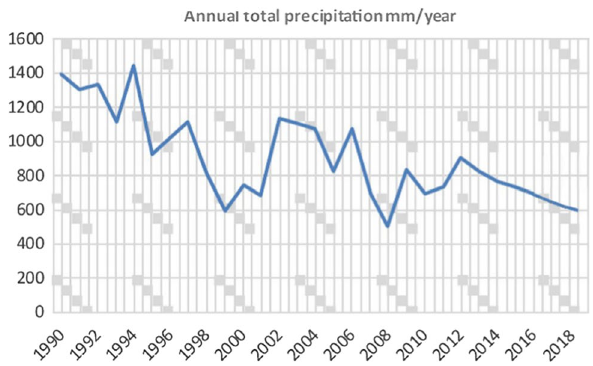
Fig. 2 The trend of precipitation in the Zrebar Lake basin (Iran Mete- orological Organization,